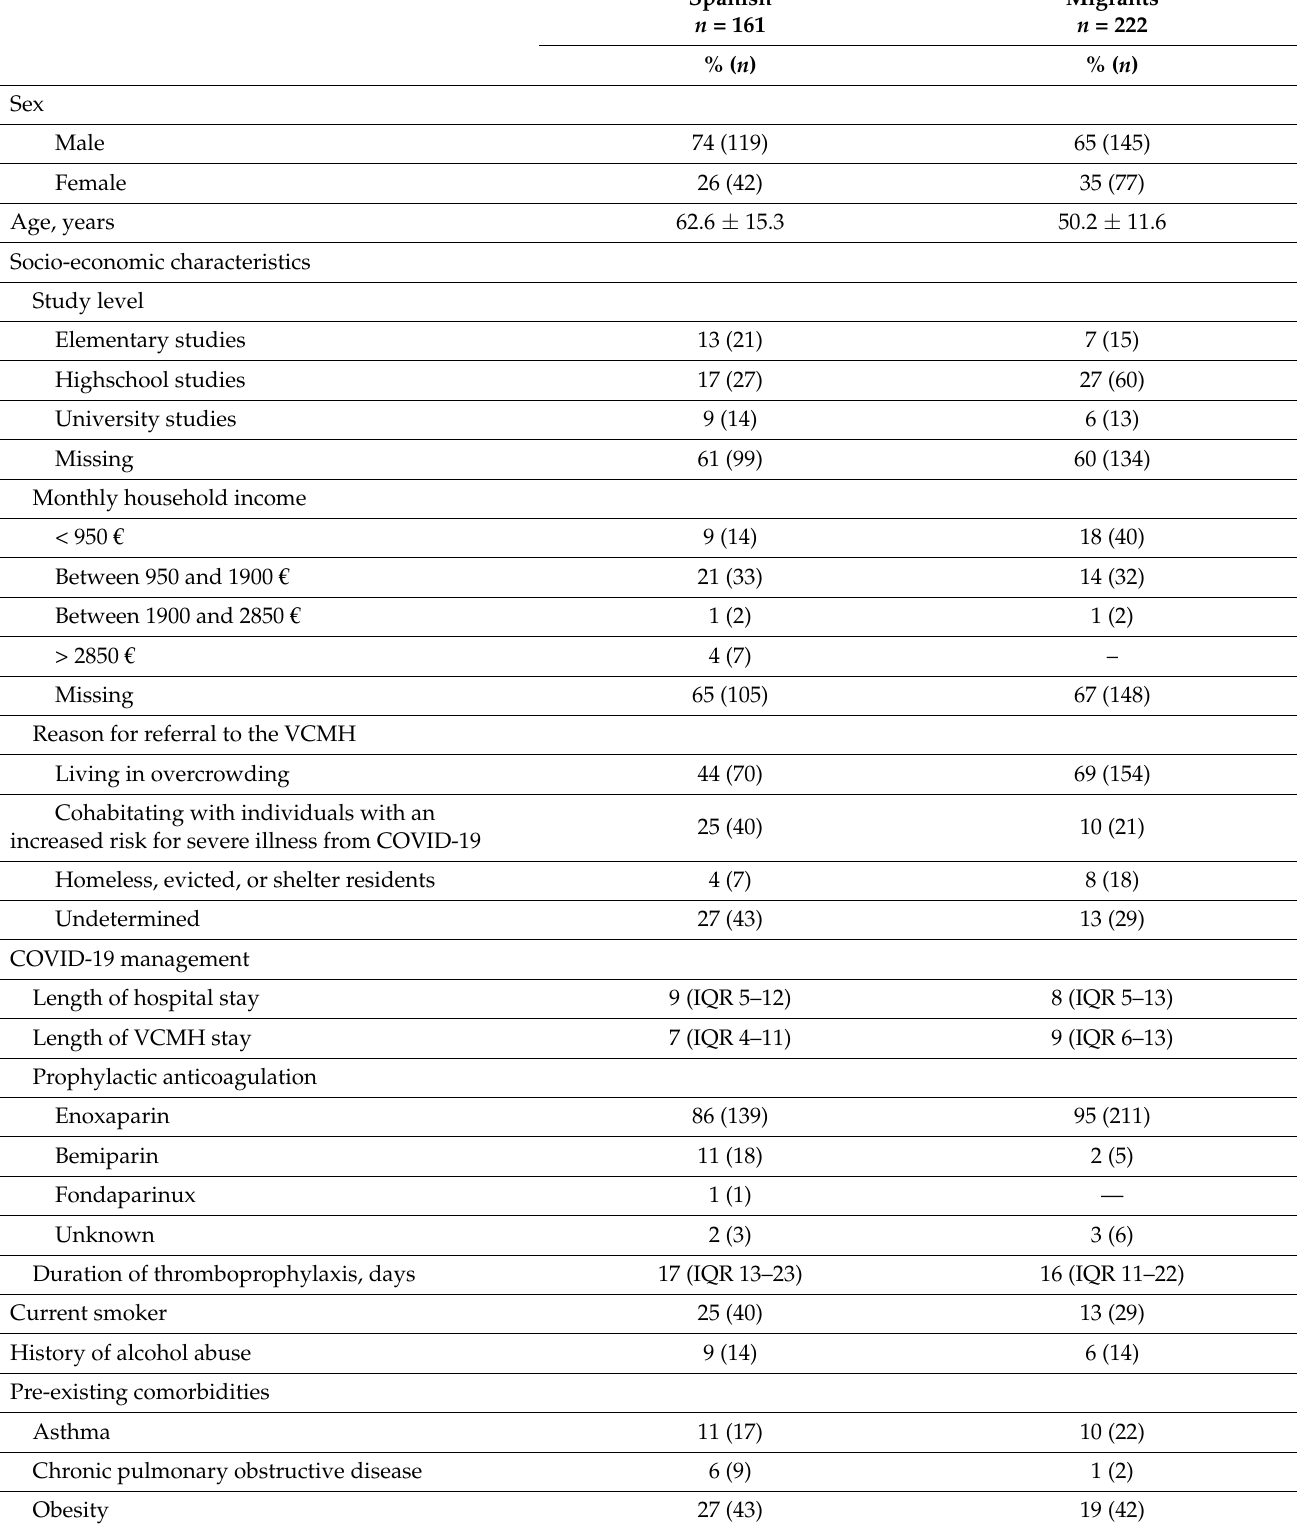
Table 1. Characteristics of migrant and Spanish